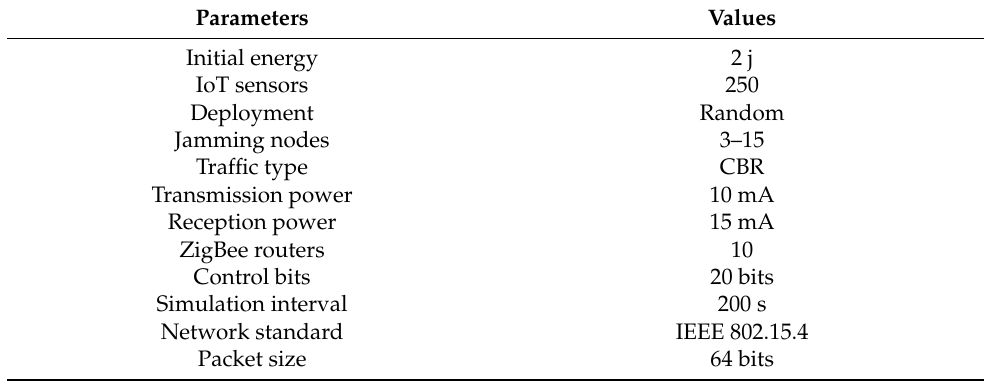
Table 1. Simulation